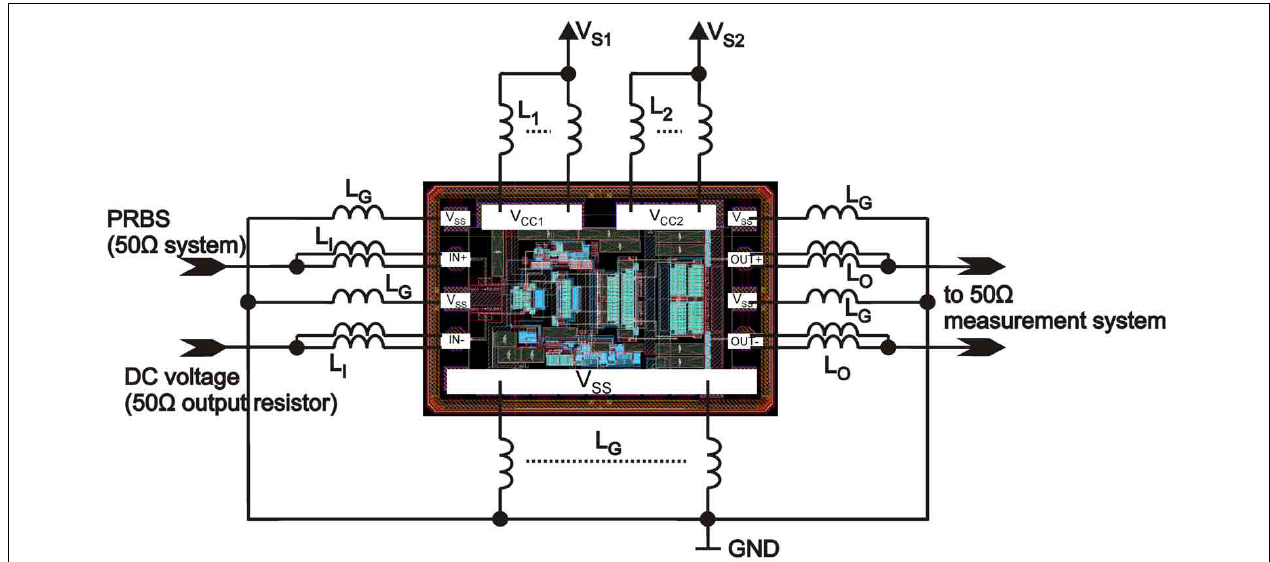
FIGURE 7 | Inductances caused by bond wires. V S1 and V S2 are supply voltage nodes on the PCB, GND is the PCB ground potential.